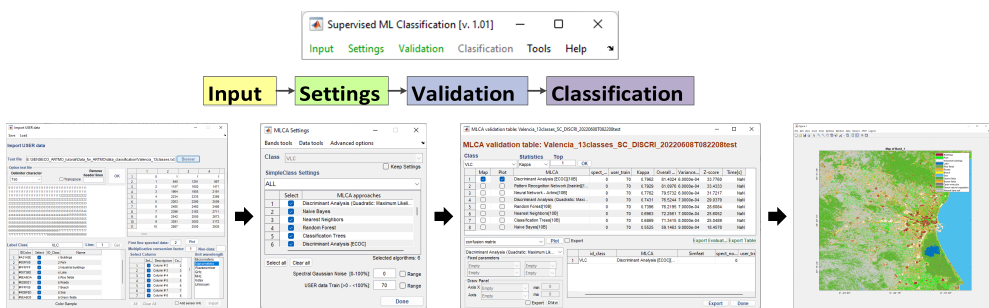
Figure 2. Schematic overview of ARTMO’s MLCA toolbox. The toolbox is on top, and the main GUIs are